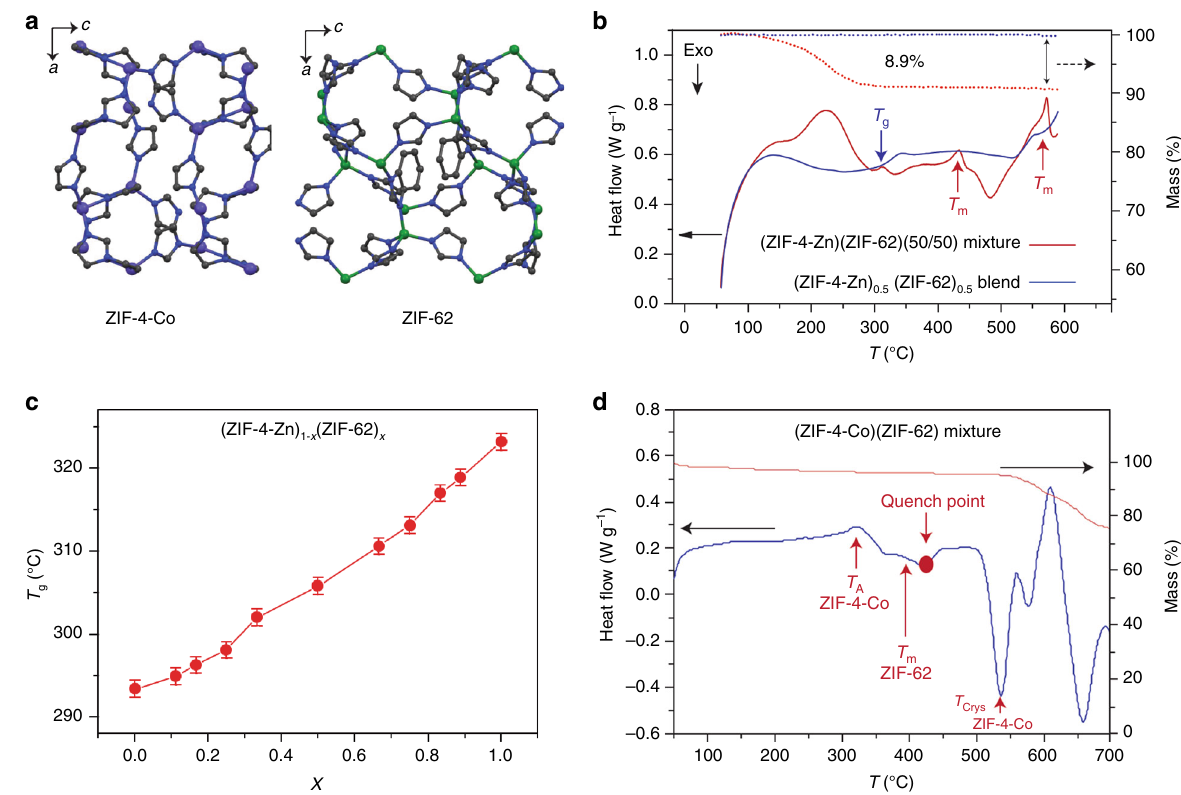
Fig. 1 MOF liquid dynamics and tailoring glass transition temperature. a View down the b axis of the unit cells of ZIF-4-Co and ZIF-62. N — dark blue, C — grey, Zn — green, Co — purple, H atoms omitted for clarity. b Enthalpy response (red curve) and mass change (dotted curve) in the physical mixture (ZIF-4- Zn)(ZIF-62)(50/50) during heating at 10 °C/min. Blue curve: reheating curve representing the enthalpy response of the corresponding glass that forms upon quenching, i.e., (ZIF-4-Zn) 0.5 (ZIF-62) 0.5 during prior cooling at 10 °C min − 1 . c Evolving glass transition of the sample series (ZIF-4-Zn) 1 − x (ZIF-62) x . d Enthalpy response (blue curve) and mass change (orange curve) of the physical mixture (ZIF-4-Co)(ZIF-62)(50/50) during heating at 10 °C min −